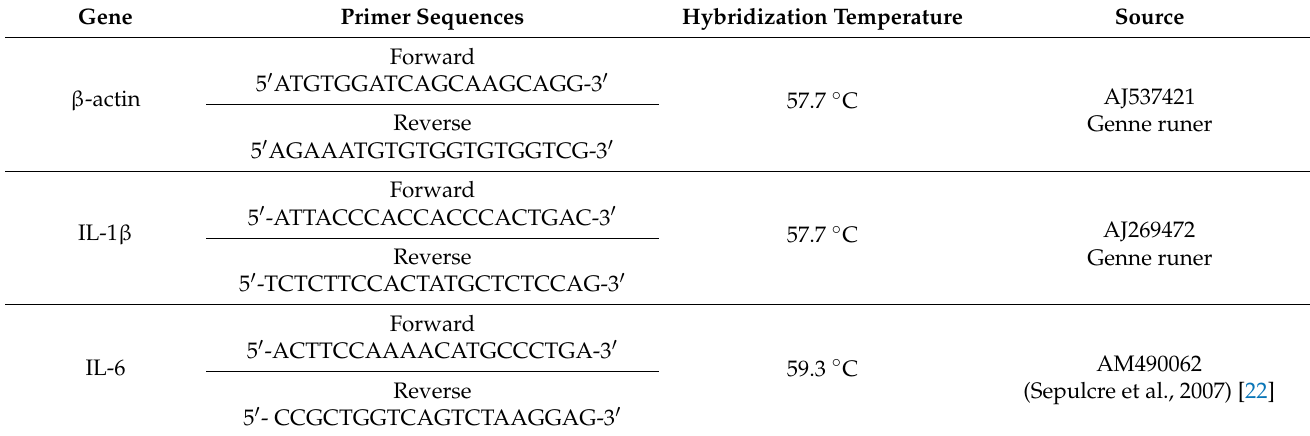
Table 2. Primer sequences and hybridization